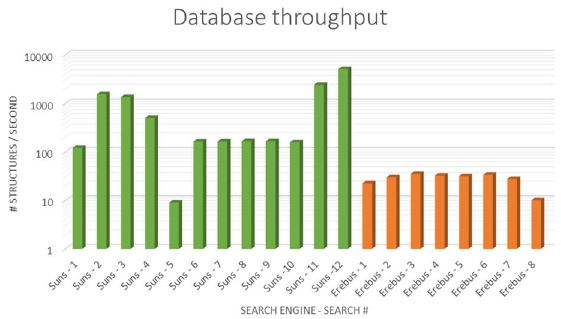
Figure 8. Throughput benchmarks. We compare throughput of search queries for both Suns and Erebus, defined as query time divided by number of models in the data set. Suns throughput is measured against a locally hosted server and the Erebus throughput data is taken from [12]. Detailed query information, including the query size in atoms and the number of matches, is provided in Table S3 and the specific query PDB files are included in the benchmark suite of suns-cmd (Software